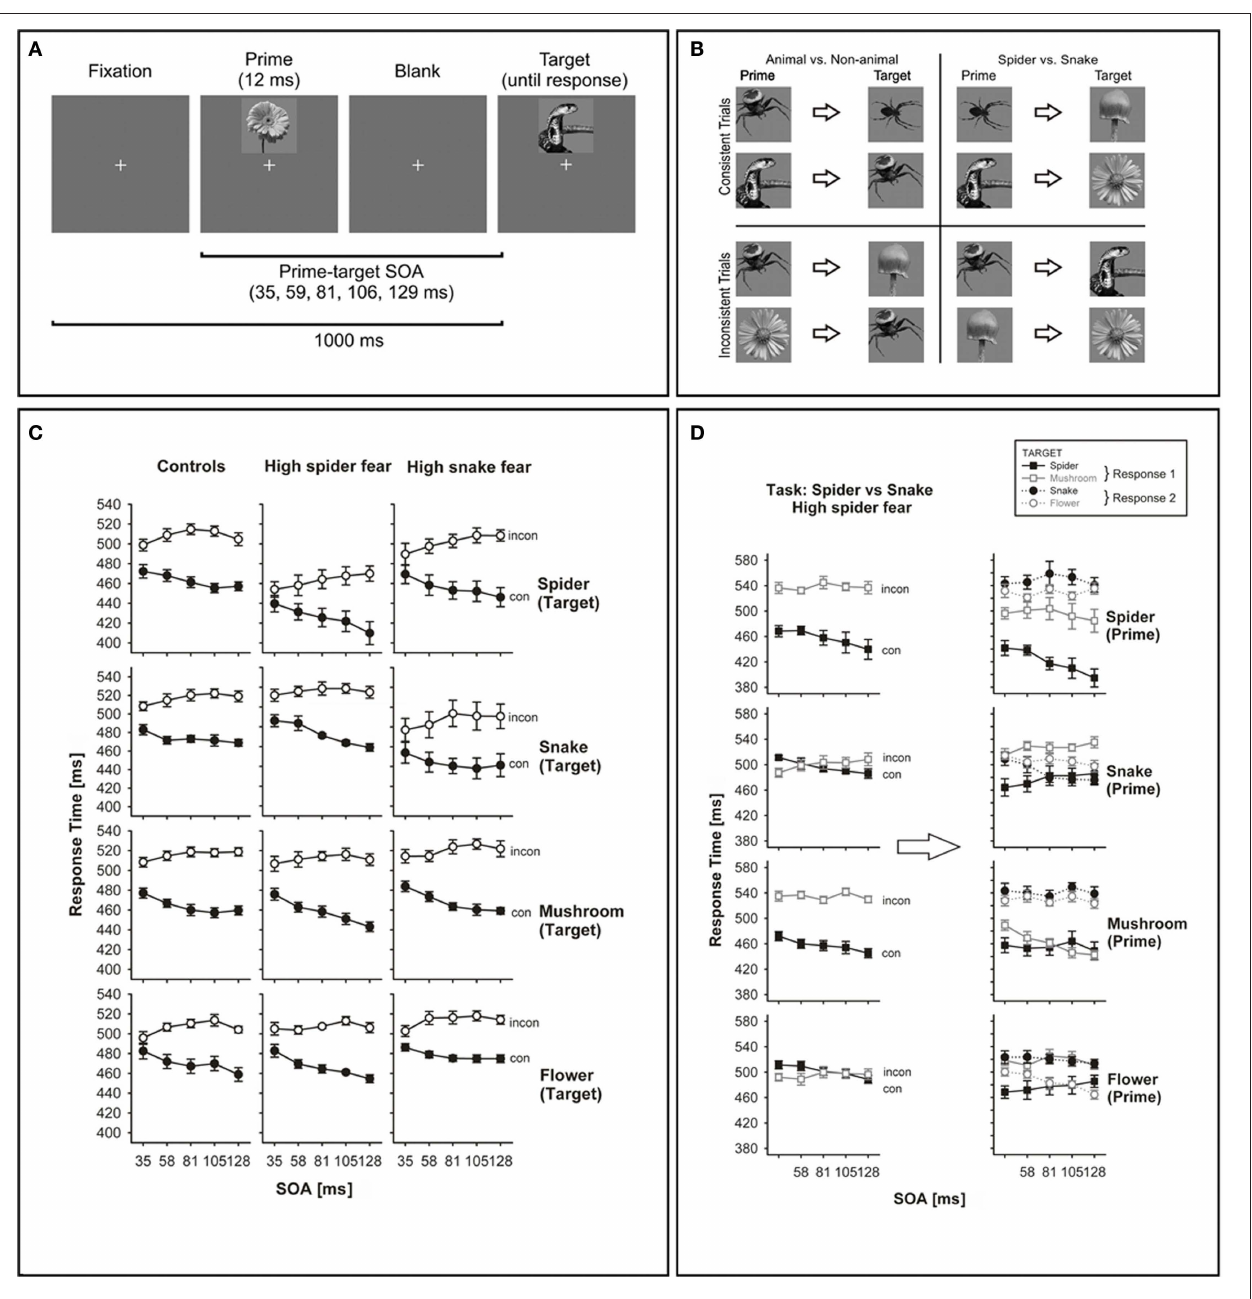
and flower targets (spider vs. snake task). (C) Priming effects in each group separated by targets, pooled across tasks. (D) Priming effects for spider-fearful individuals in the spider vs. snake task. The left panel shows effects for response-consistent and response-inconsistent primes, the right panel shows effects for all